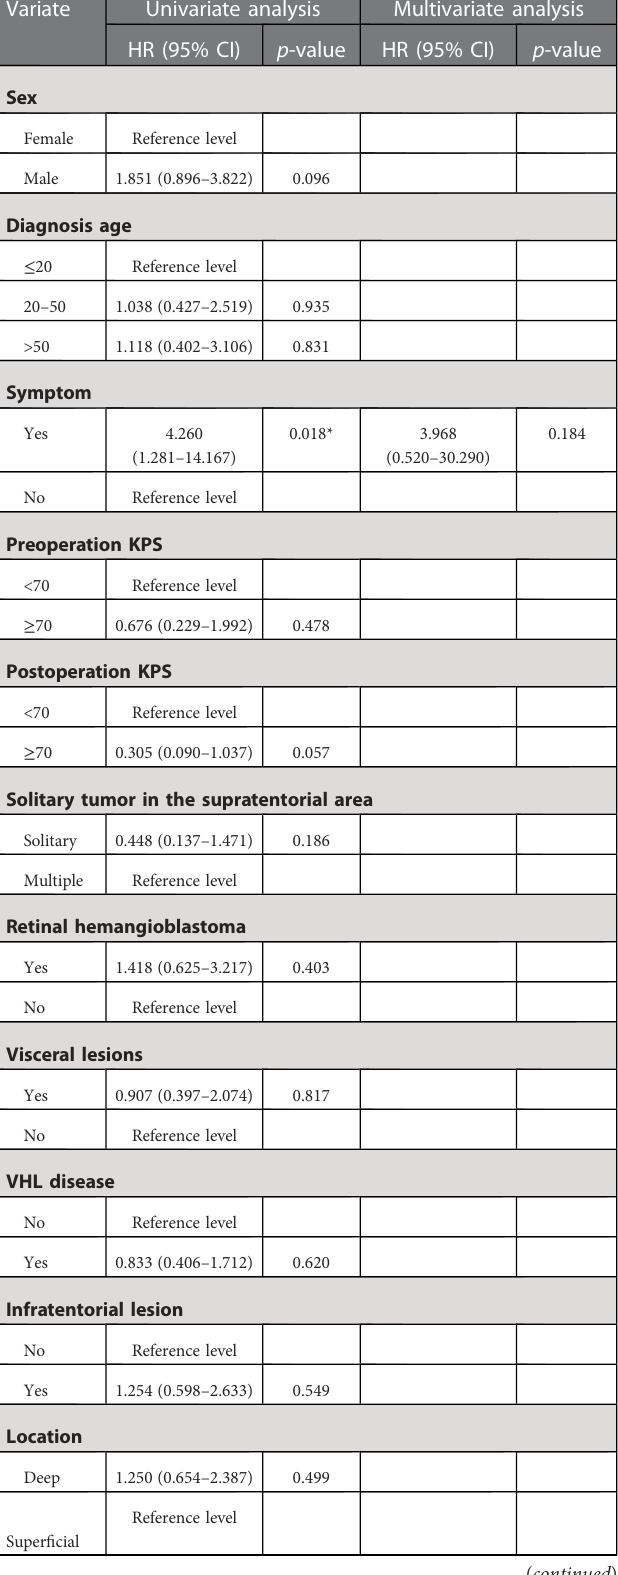
TABLE 3 Univariate and multivariate Cox regression analyses of potential risk factors in fl uencing the PFS of patients with supratentorial